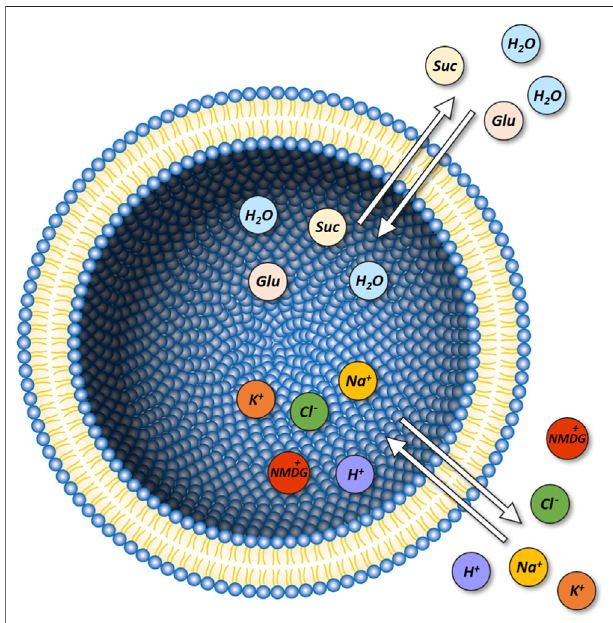
FIGURE 1 | Model of a unilamellar vesicle. Initial NaCl , KCl , buffer and proton concentrations inside and outside the vesicle can be set to user- de fi ned values. An osmotic solute (e.g., sucrose) can be applied to the extra- vesicular side to simulate water fl ux experiments utilizing a stopped- fl ow device.The lipidscomprisingthemembrane areshown withtheir headgroups in blue and their acyl chains in yellow. The arrows indicate passive permeation of H + , Na + , NMDG + , Cl − , and K + . In the model we also accounted for passive fl ux of water (light blue circles), glucose, sucrose and NMDG 0 (beige circles).